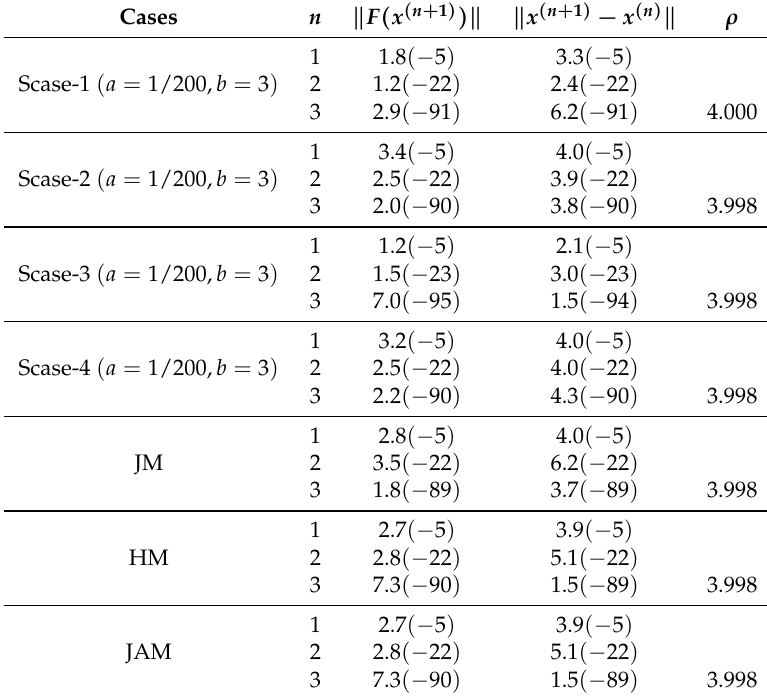
Table 8. Convergence behavior of different fourth-order methods for Example 5.